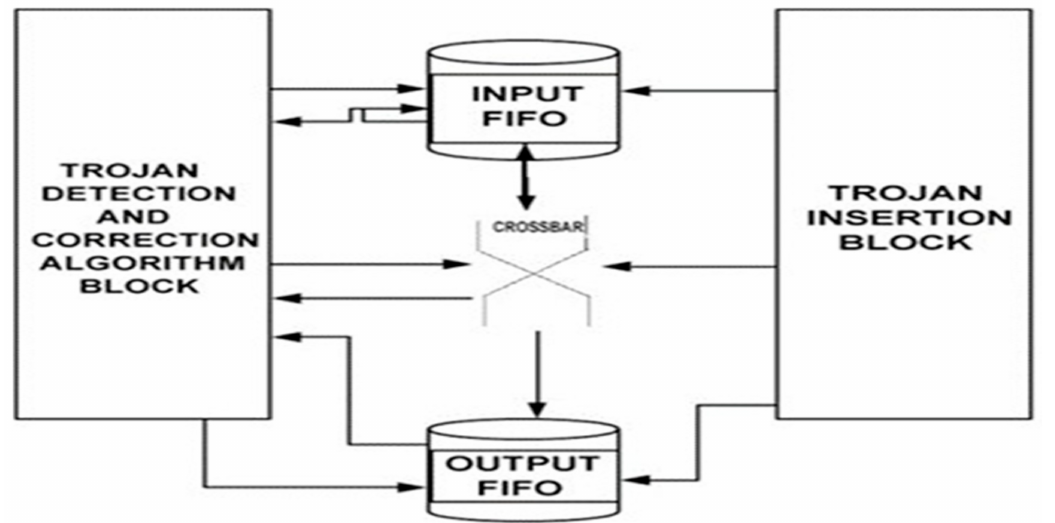
Figure 6. Router architecture used in this